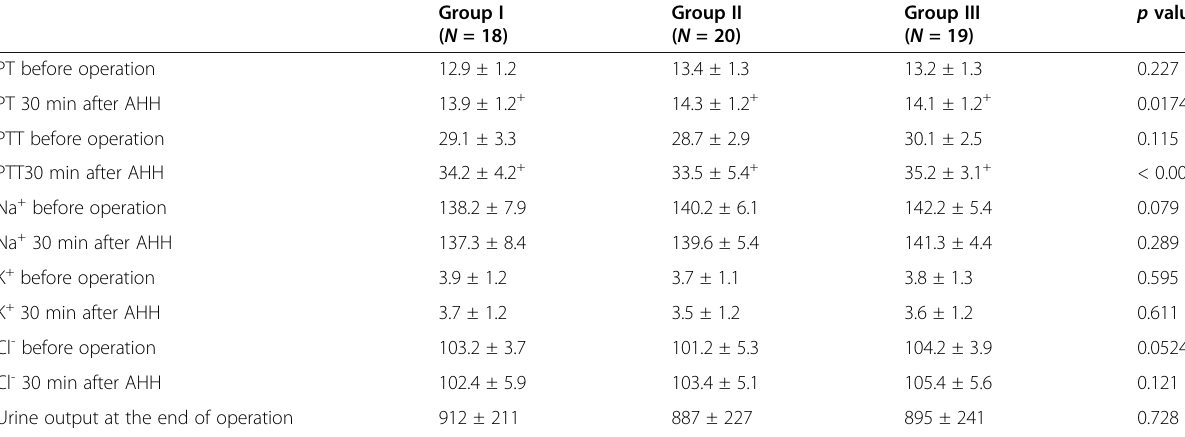
Table 7 Coagulation profile, electrolytes, and urine output in the three study